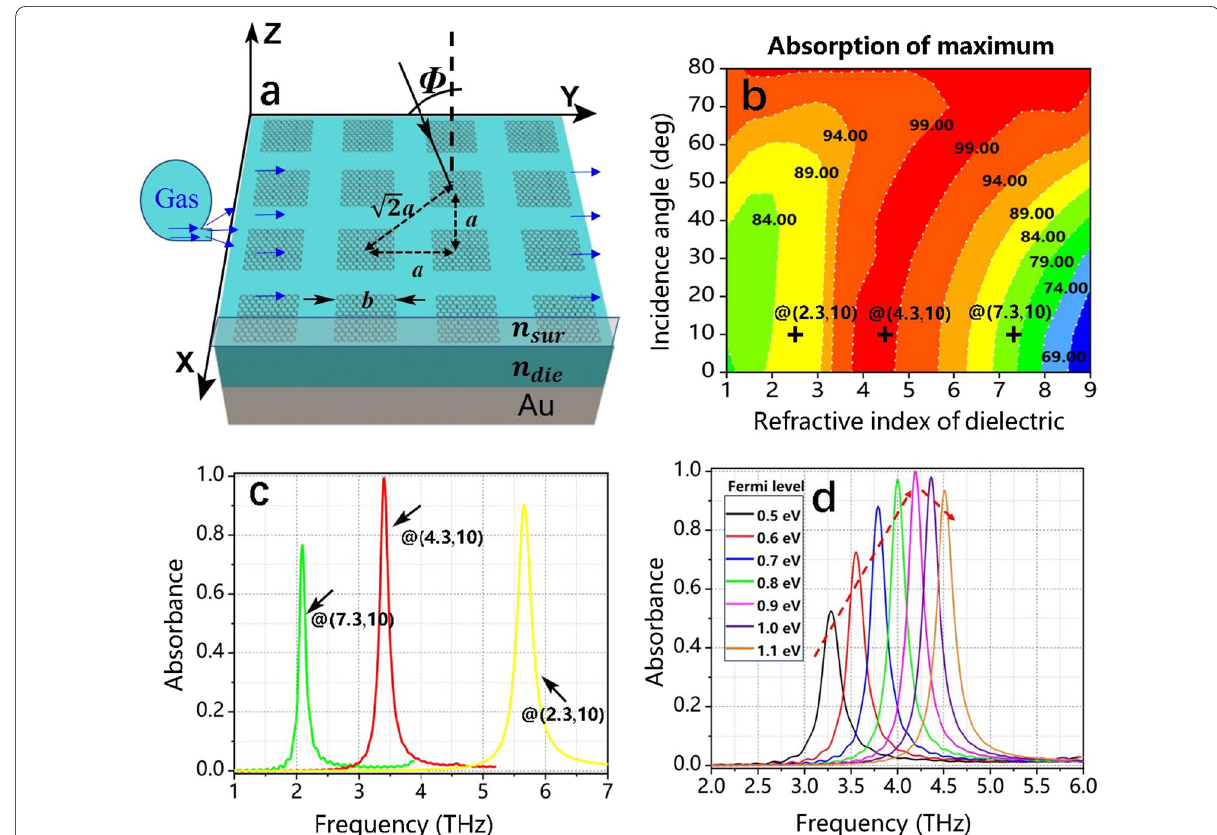
Fig. 3 a The periodic structure of four graphene blocks. b Three-dimensional diagram of the maximum absorption with incident light Φ and refractive index n d of the dielectric. c The absorption spectrum at positions @(2.3, 10), @(4.3, 10) and @(7.3, 10) of ( b ), respectively. d The FDTD numerical absorption spectrum with the Fermi level of graphene changing from 0.5 to 1.1 eV ( n